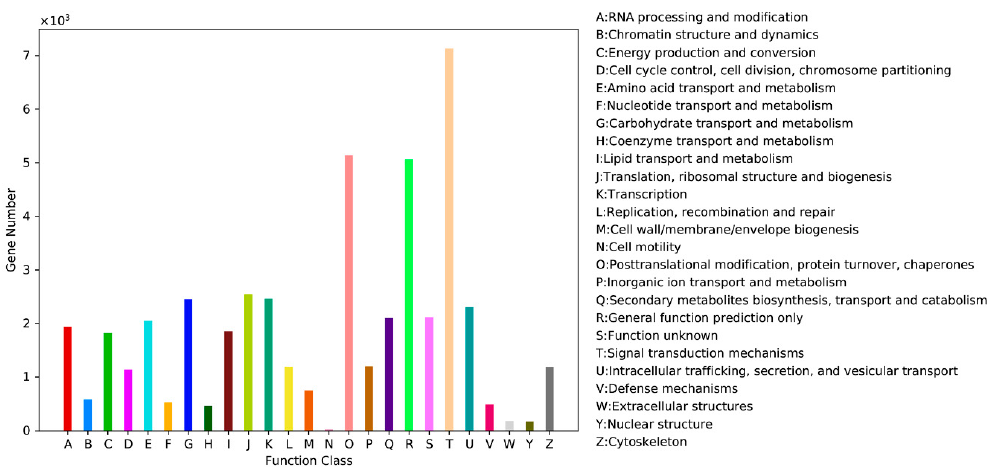
Figure 2. Histogram presentation of clusters of orthologous groups from the Kentucky Bluegrass transcriptome.